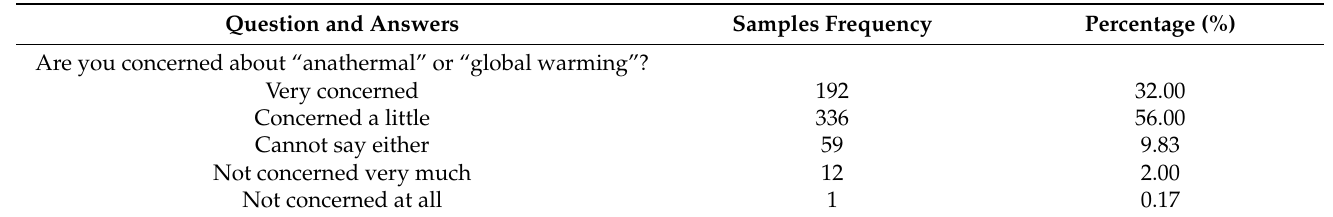
Table 4. Institutional investors in Shanghai’s interest in global environmental issues ( n =